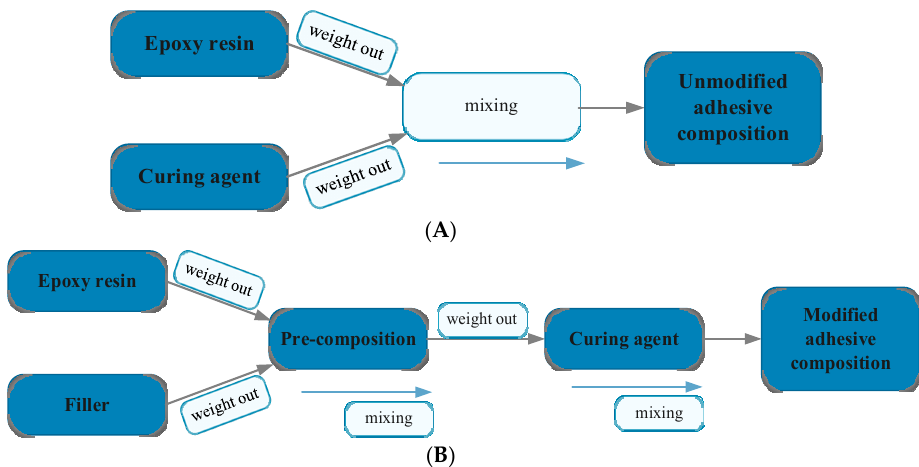
Figure 1. Schematic diagram of the sequence of activities performed during preparation: ( A ) unmodified adhesive compositions and ( B ) modified adhesive compositions.